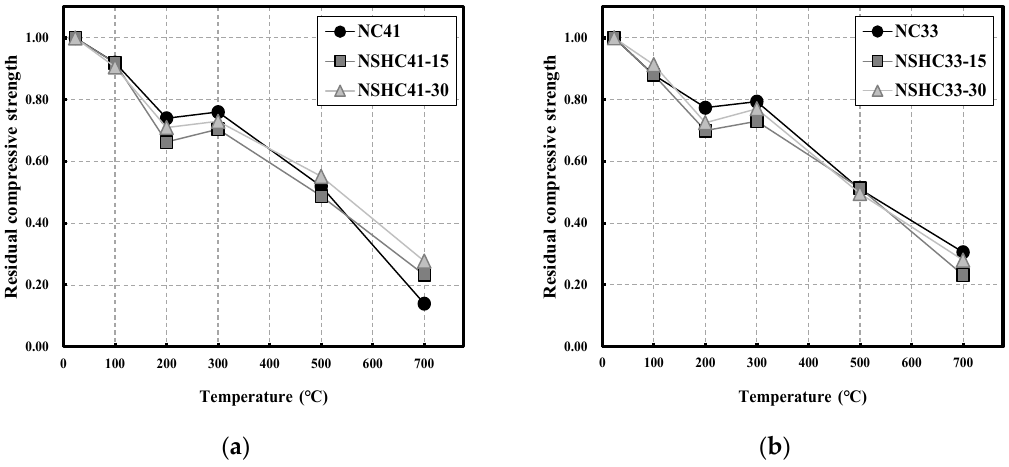
Figure 7. Residual compressive strength of NC and NSHC after high-temperature exposure: ( a ) W/B 41; ( b ) W/B 33.